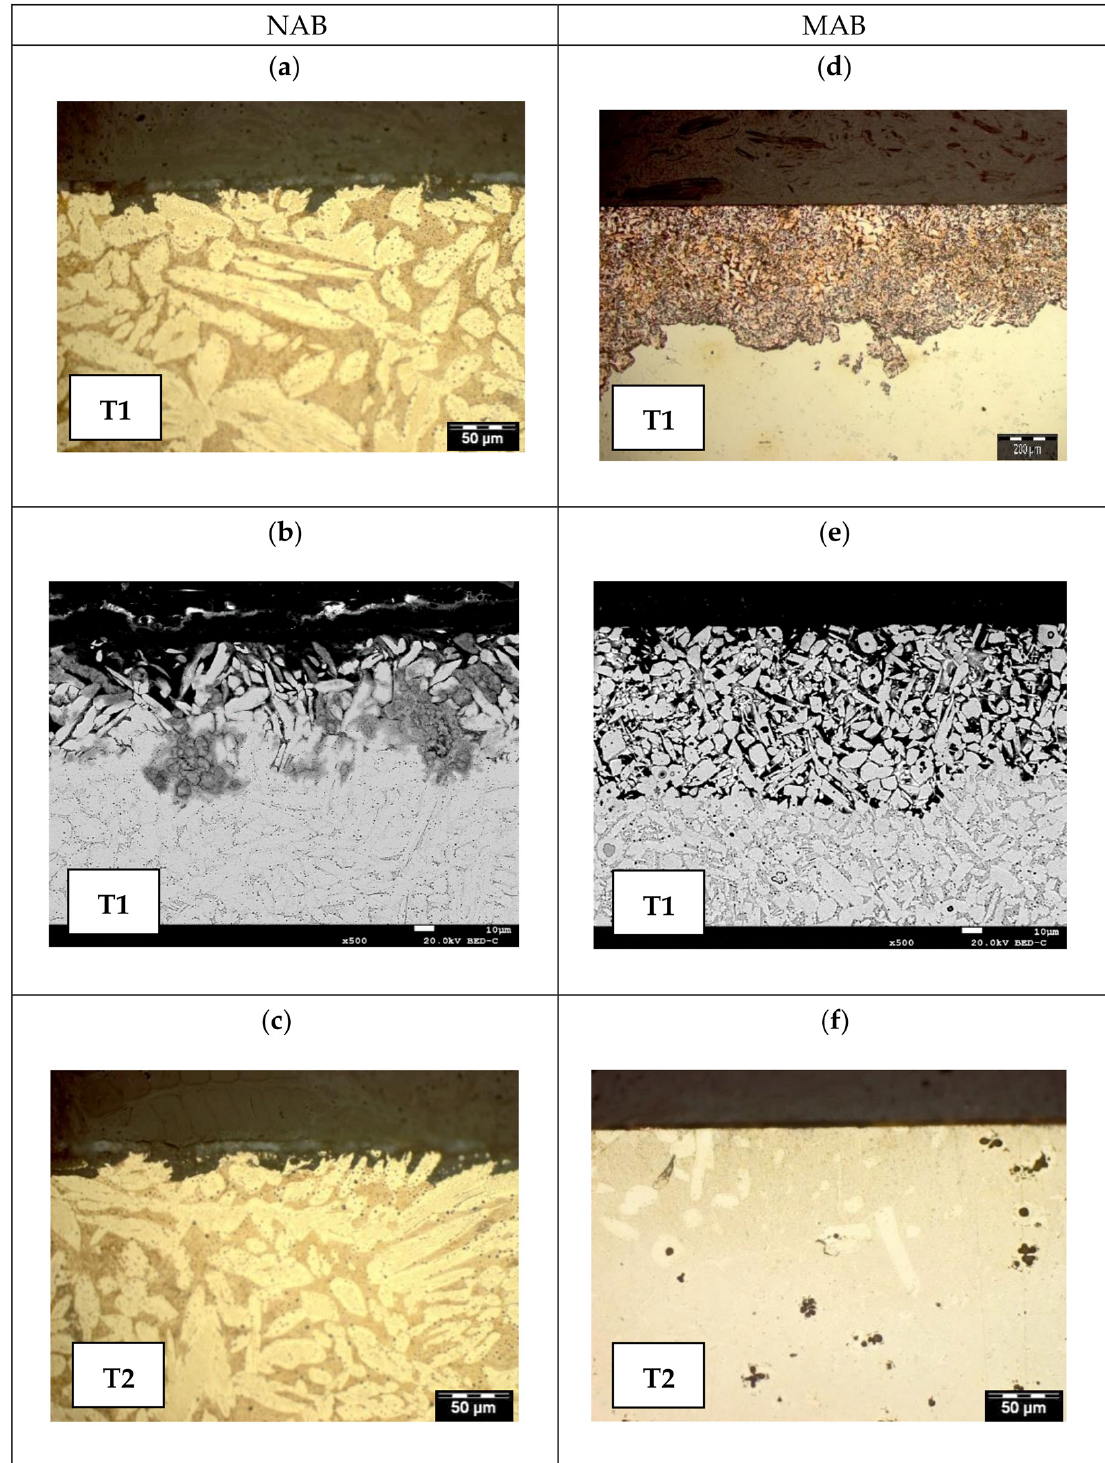
Figure 9. LOM pictures of T1 and T2 samples after potentiostatic corrosion testing in SSW at − 100 mV SCE for NAB ( a , c ) and − 150 mV SCE for MAB ( d , f ), and SEM pictures of T1 samples ( b , e ).